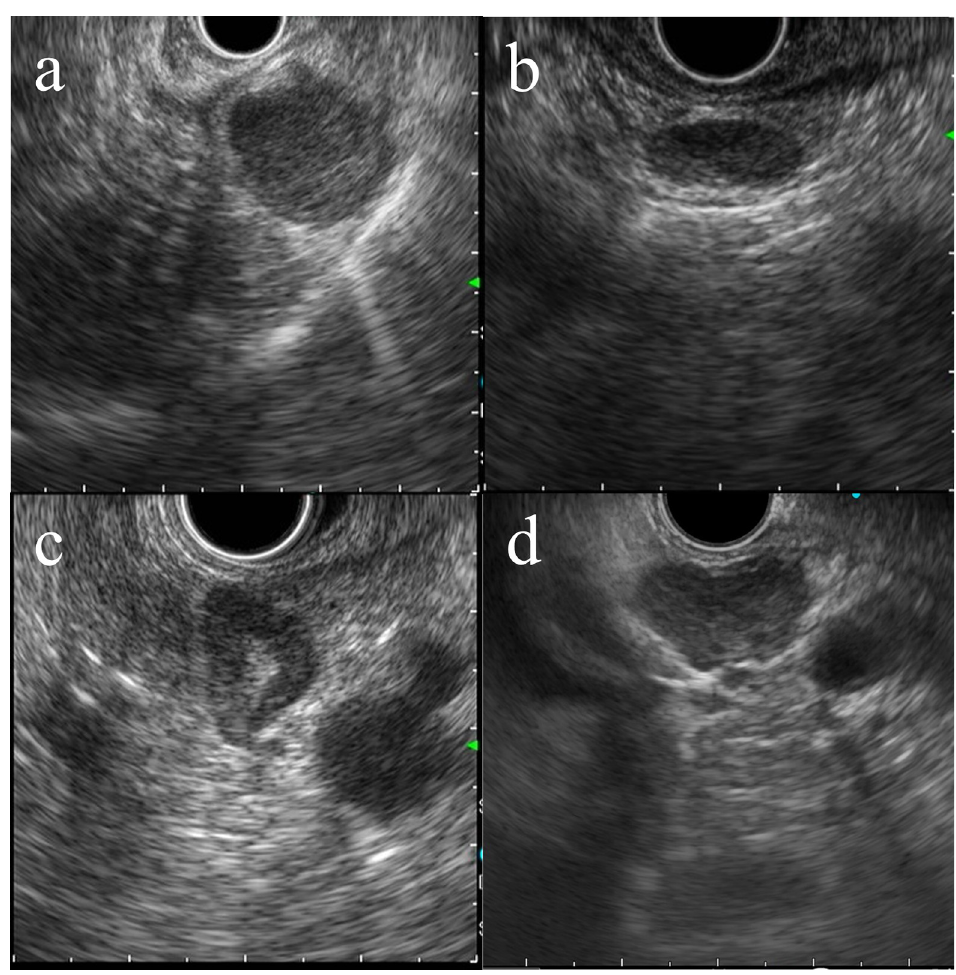
Fig 1. The shape classification of swollen lymph nodes on EUS image. (a) round shape, (b) oval shape, (c) triangle shape, and (d) polygonal shape.